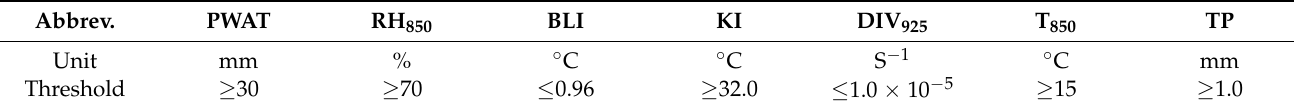
Table 2. Thresholds of parameters used to define